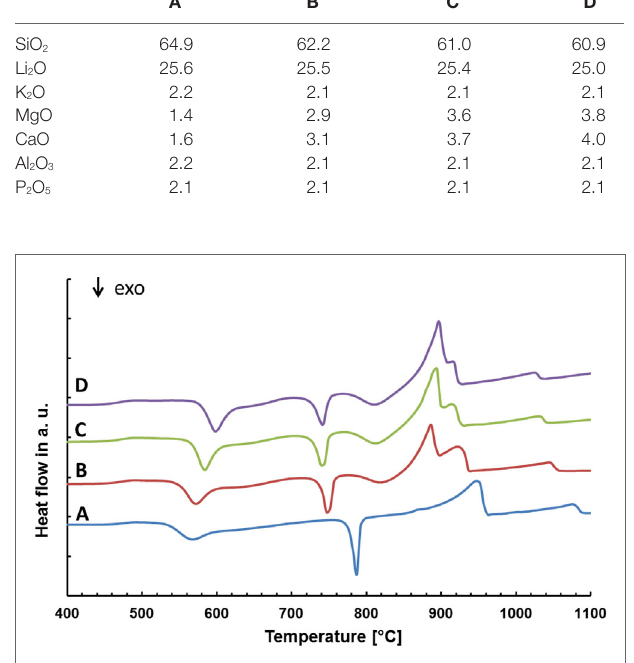
FigUre 1 | Thermal analysis of the different base glasses .